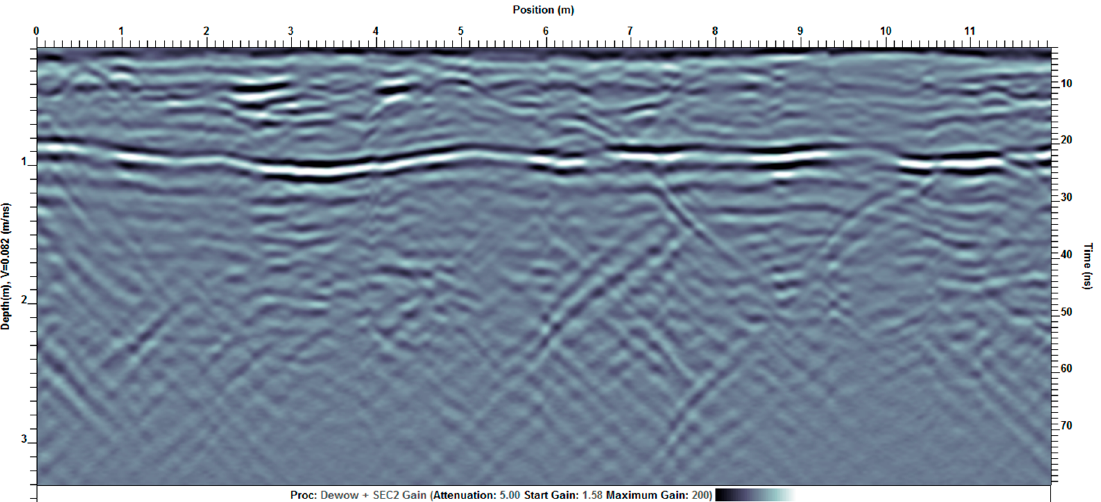
Figure 7. A sample GPR profile from Cape Espenberg. The permafrost interface is clear at 20–23 ns. The active layer exhibits an average velocity of 0.82 m/ns for a depth estimate to the frozen interface of ca. 1 m. This velocity, however, yields inaccurate depth estimates at depths greater than 1 m because the frozen ground exhibits an average velocity of 0.12 m/ns. This data set was collected within several days of the Cape Krusenstern 2016 expedition data and shows the frozen interface (and velocities) are comparable to those observed at the Old Whaling Ridge.